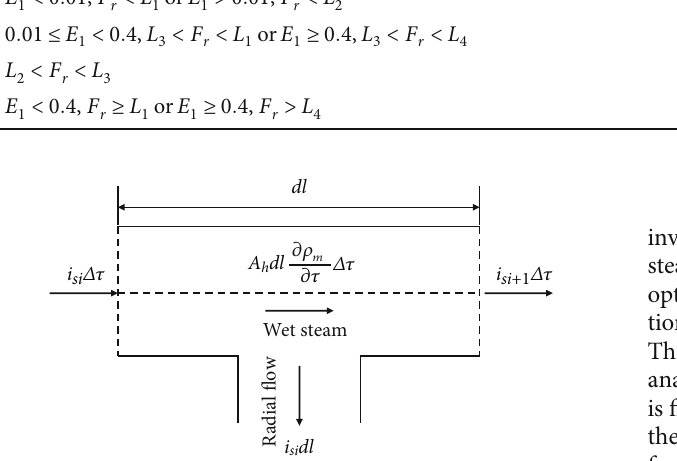
Table 1: Modi fi ed Beggs-Brill fl ow pattern criteria. Criteria Flow pattern